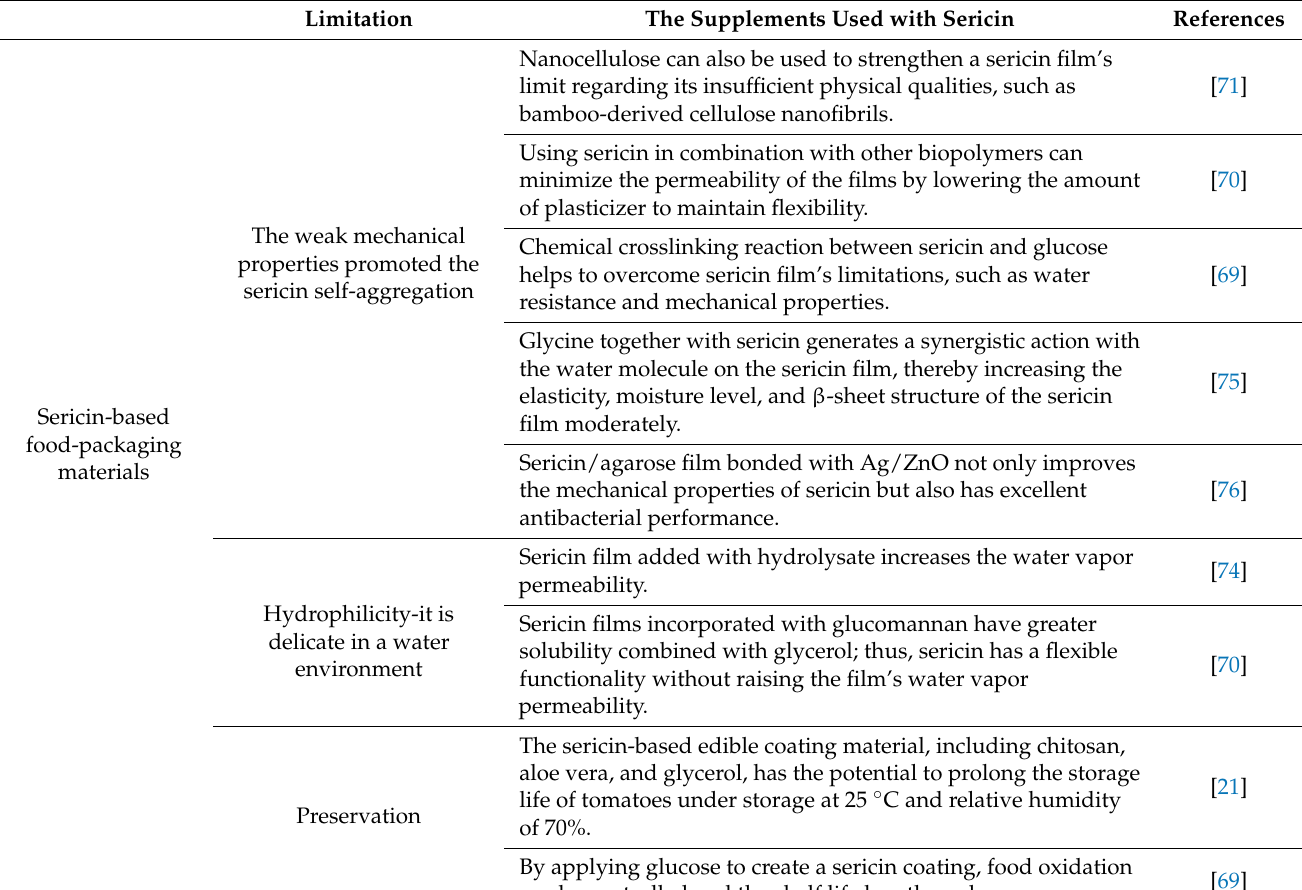
Table 4. Use of sericin in combination with other materials for application in food-packaging